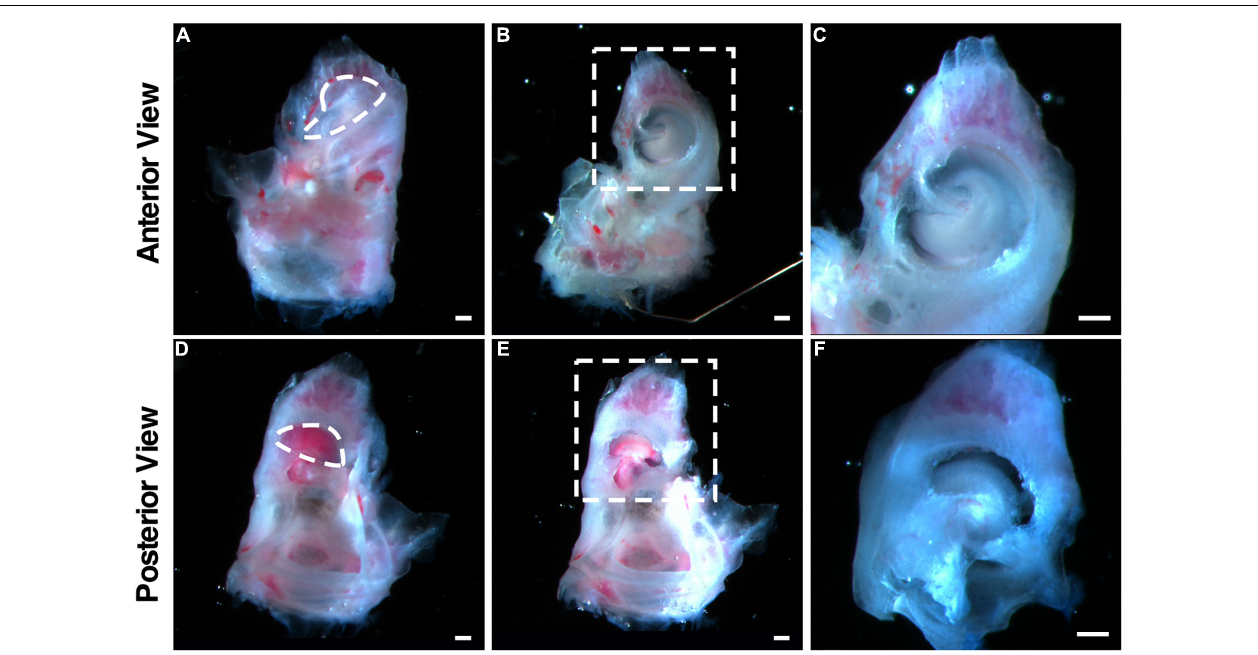
FIGURE 1 | Illustration of the dissection procedure that maintains the architecture of the adult cochleae used in explant culture. (A–C) Freshly dissected adult mouse cochlea viewed from the anterior. The dotted circle in (A) indicates the openings to be created by removing the bony shell in the apex. (B) The cochlea after removing the bony shell with the exposure of the apex. (C) The enlarged image of the dotted box shown in (B) . (D–F) Freshly dissected adult mouse cochlea viewed from the posterior. The dotted circle in (D) indicates the openings to be created by removing the bony shell in the base. (E) The cochlea after removing the bony shell with the exposure of the base. (F) The enlarged image of the dotted box shown in (E) . Scale bars: 0.2